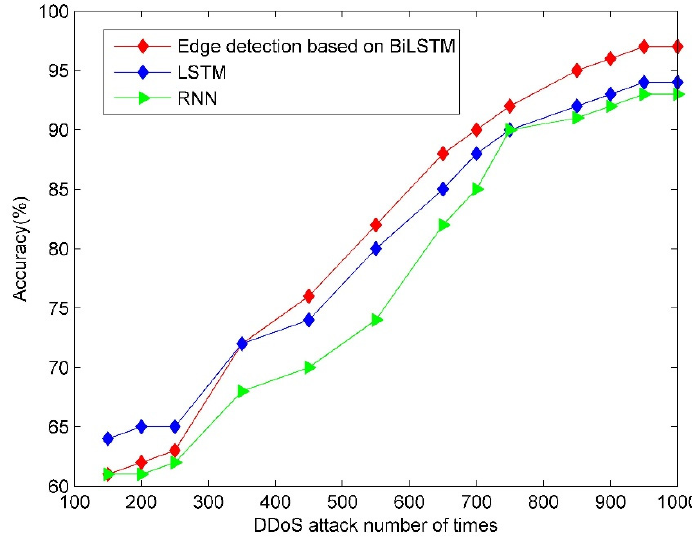
Figure 12. Comparison of the accuracy of different experimental schemes.